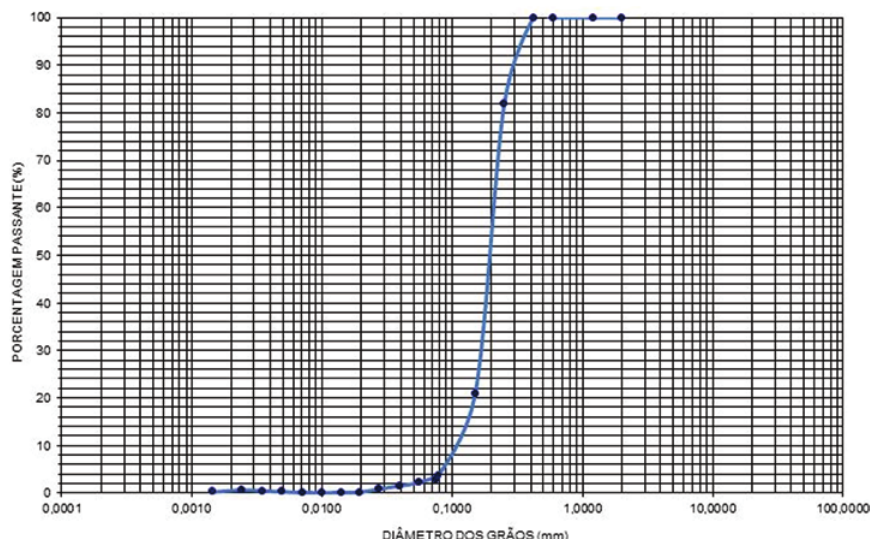
indicates an almost vertical granulometric curve, ie the diameters vary in a small range, indicating a sample with uniform